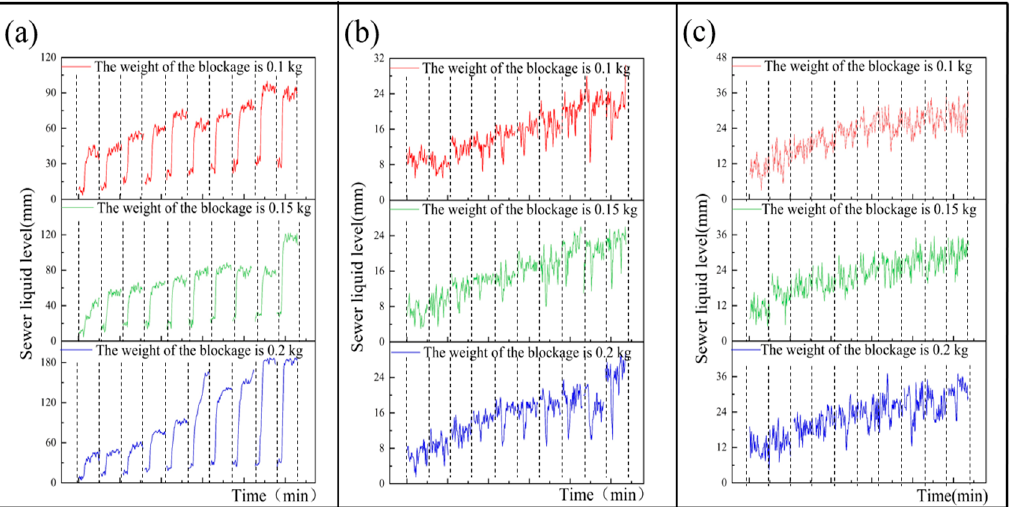
Figure 5. When the flow rate in the sewer ranges from 0.5 to 5 m 3 /h, the liquid level change in the upstream and downstream of the blocking point in the pipeline of DN150 at PW2: ( a ) The liquid level change of the DN100 sewer at PW1, and it is 1 m upstream of the blocking point; ( b ) The liquid level change of DN150 sewer at PW4, and it is 29.55 m downstream of the blocking point; ( c ) The liquid level change of DN200 sewer at PW6, and it is 60.4 m downstream of the blocking point.